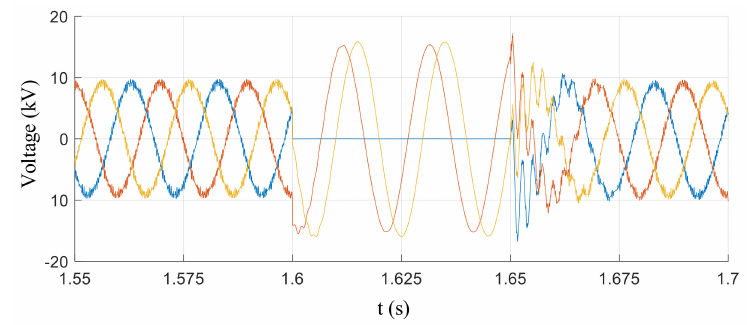
Figure 14. Relative ground voltage waveform of the 10 kV AC bus.